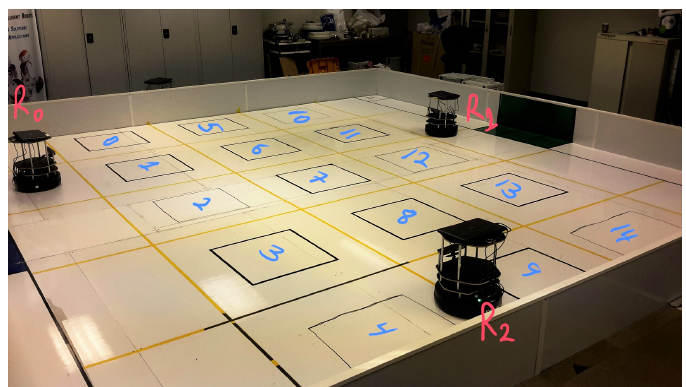
Figure 16. Experimental environment with three Turtelbot2 robots ( R 0 , R 1 ,and R 2 ) and 15 locations where a task can possibly appear.